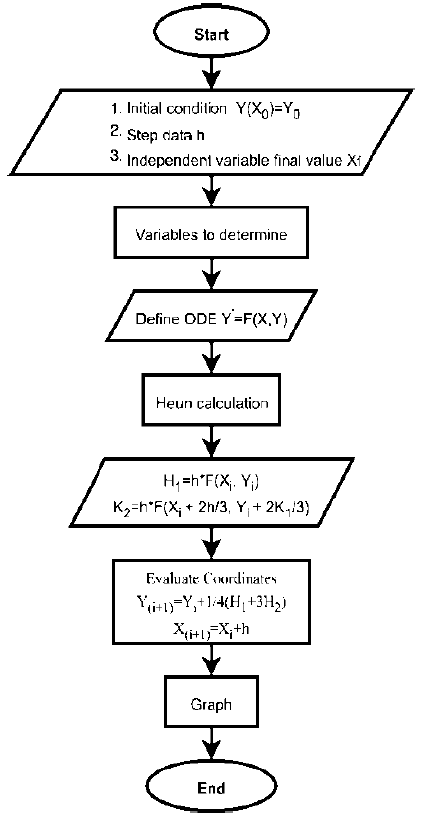
Figure 3. Flow chart of Heun’s 4th order method in MATLAB ® .